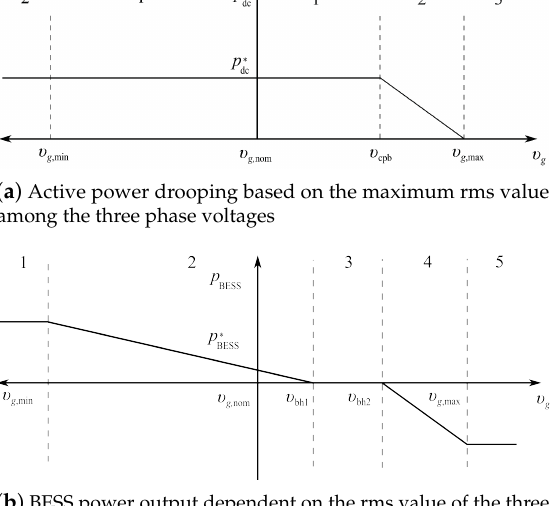
Figure 2. Active power droop controller and BESS controller used for the integration in the examined control